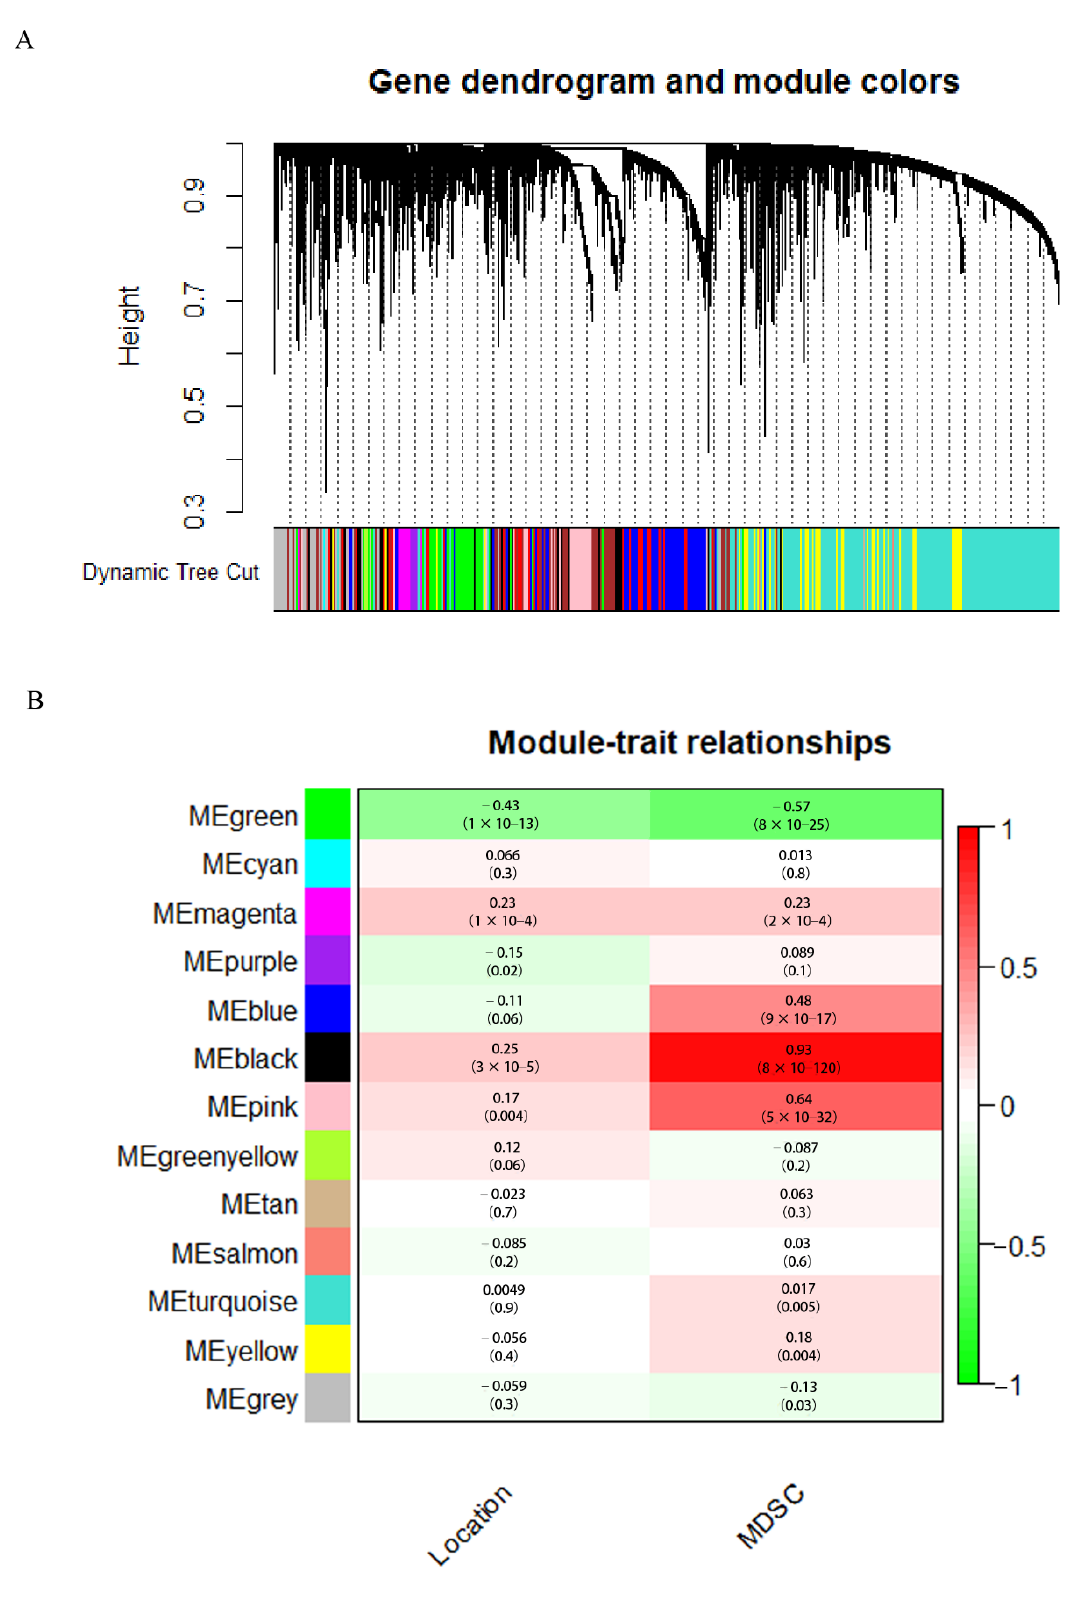
Figure 4. ( A ) Analysis of gene co-expression networks with weighted dendrograms and node color. ( B ) Analysis of gene modules in relation to clinical information.